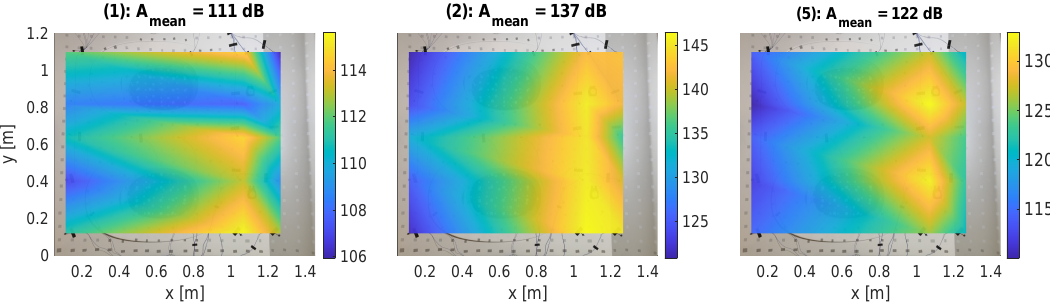
Figure 7. Vibration level distribution on the lining surface. Two different virtual microphone configurations (2 and 5) are compared to the the uncontrolled case